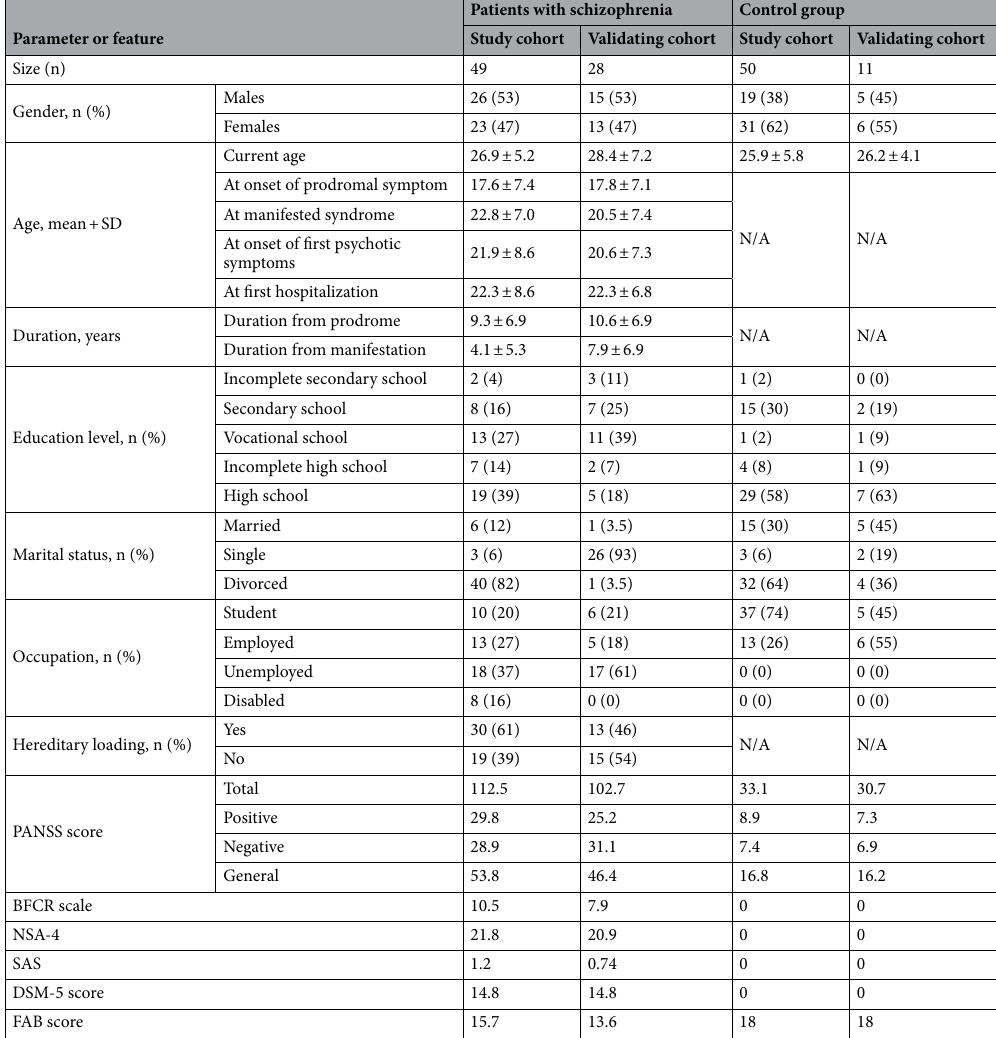
Table 4. Sociodemographic, clinical and psychometric characteristics of patients with schizophrenia and group of healthy volunteers participated in the study. PANSS positive and negative syndrome scale, BFCR scale Bush-Francis Catatonia Rating Scale, NCS4 the 4-item negative symptom assessment, SAS Simpson- Angus Scale, DSM-5 Diagnostic and Statistical Manual of mental disorders, fifth edition, FAB